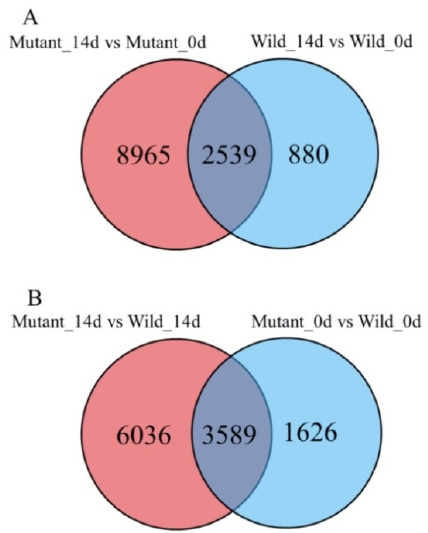
Figure 4. Venn diagrams of DEGs in different comparisons. The numbers indicate unique and common DEGs in different comparisons. ( A ) Unique and common DEGs between Mutant_14d vs. Mutant_0d and Wild_14d vs. Wild_0d; and ( B ) unique and common DEGs between Mutant_14d vs. Wild_14d and Mutant_0d vs. Wild_0d.